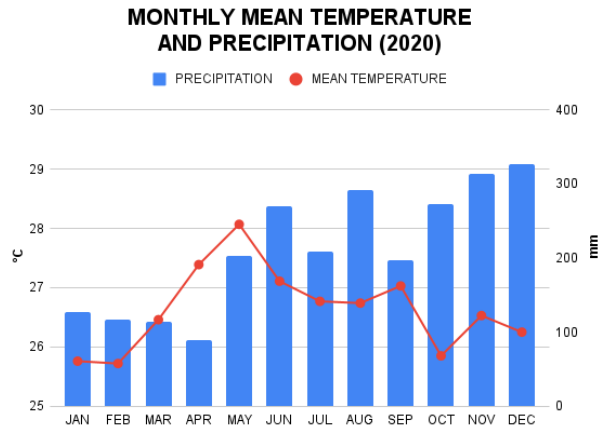
Figure 2. Monthly mean temperature and precipitation in the Philippines in 2020. May was the warmest month and the highest monthly rainfall occurred in